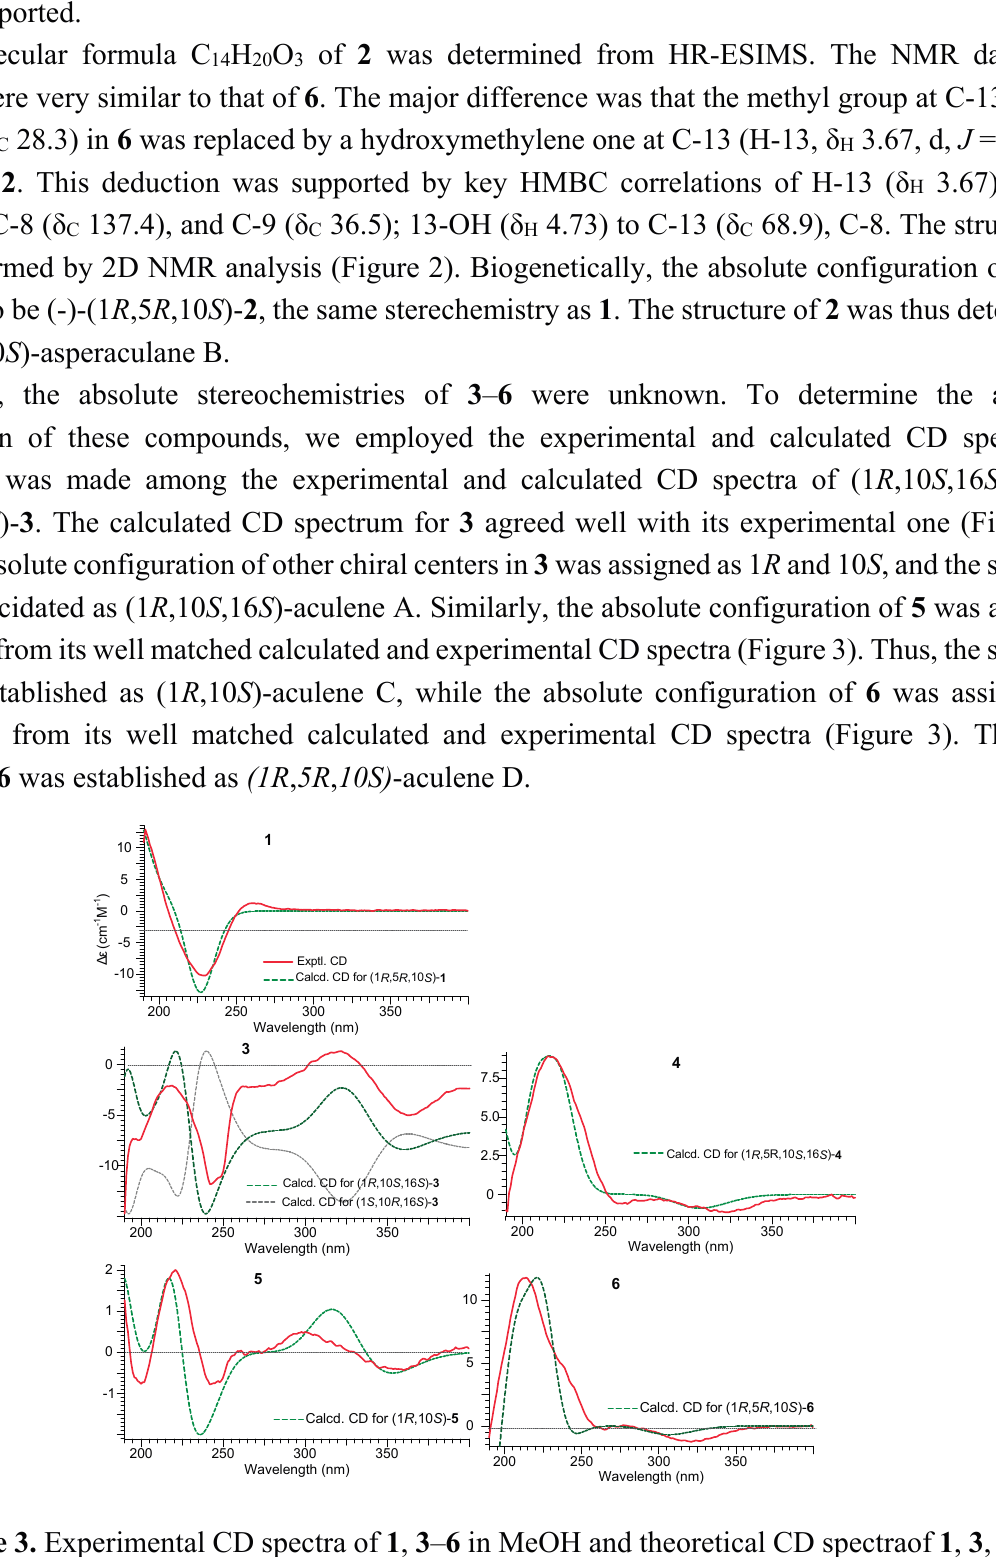
Figure 3. Experimental CD spectra of 1 , 3 – 6 in MeOH and theoretical CD spectraof 1 , 3 , 5 , and 6 calculated at CAM-B3LYP/TZVP//B3LYP/6-311+G(d,p) level, and 4 calculated at CAM-B3LYP/SVP//B3LYP/6-31+G(d,p) level as Boltzmann